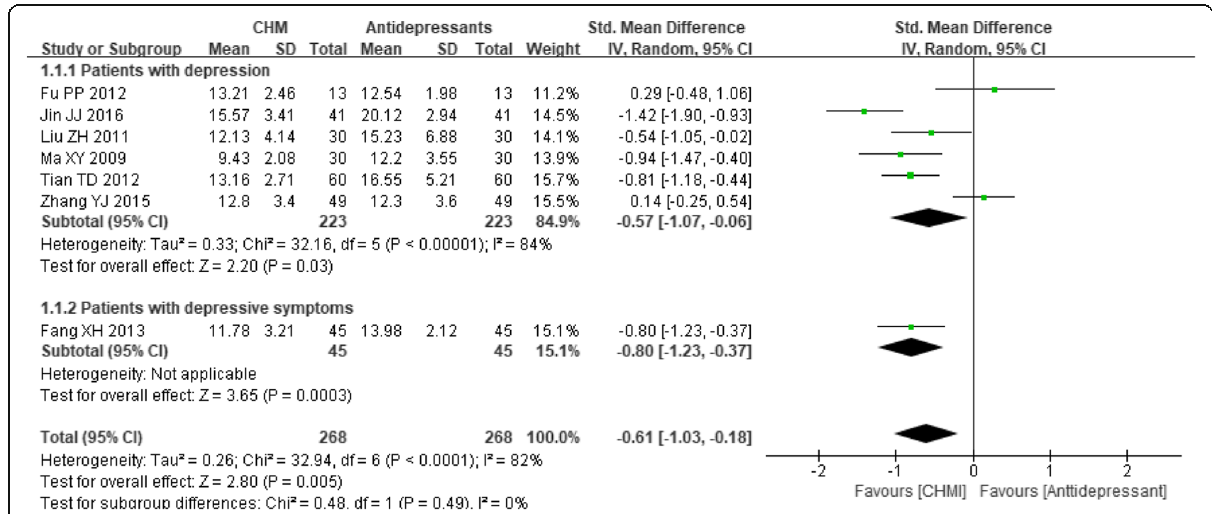
Fig. 4 Forest plot of mean depression scores for CHM versus